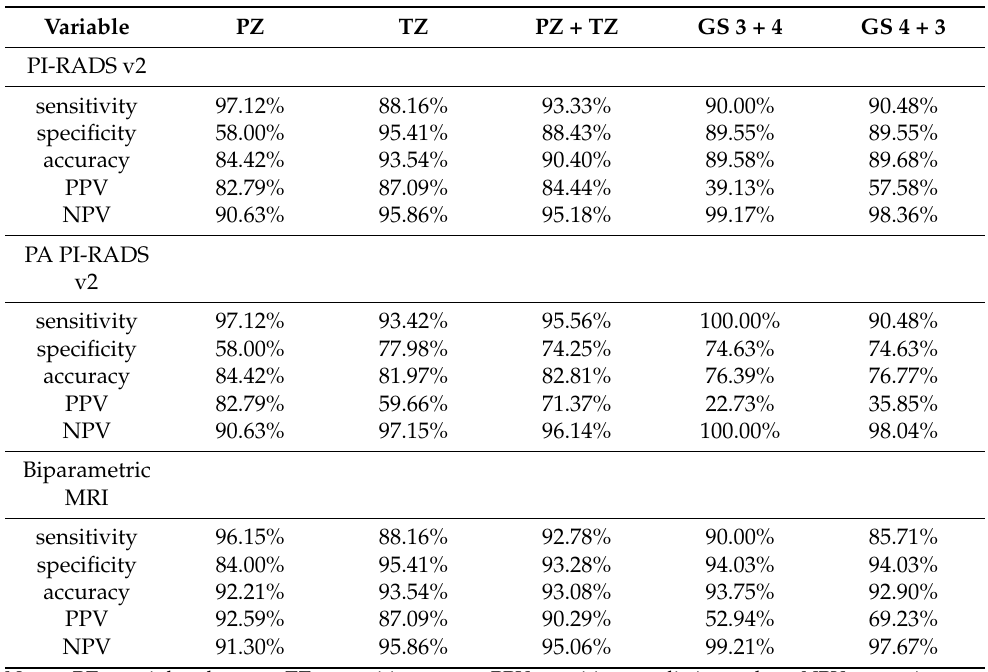
Table 6. Diagnostic performance of PI-RADS v2, PA PI-RADS v2, and biparametric MRI protocols for prostate